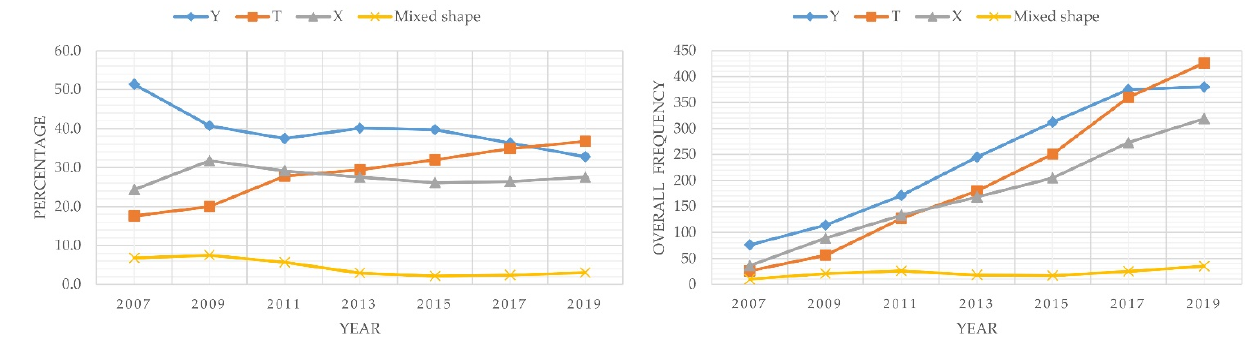
Figure 7. The percentage and frequency of different junction types 2007–2019.